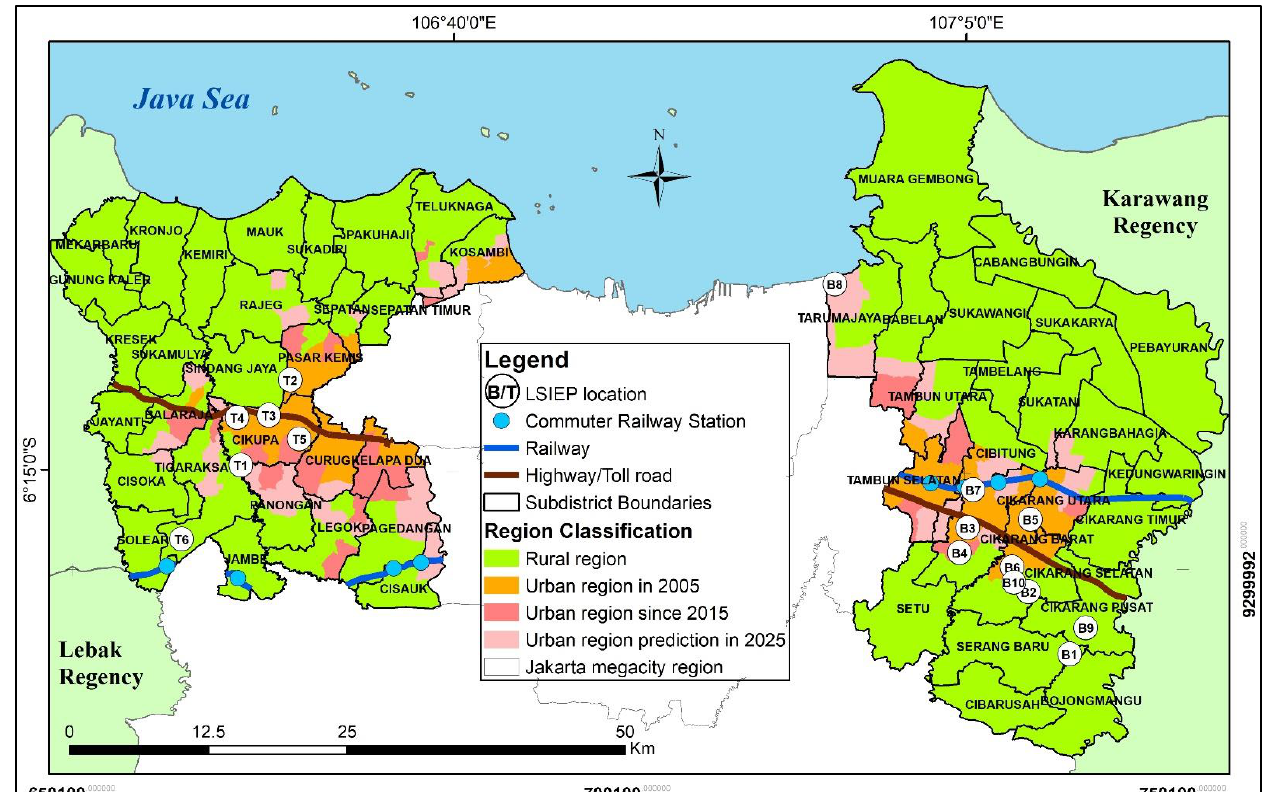
Figure 10. Regional typology prediction (2025) based on the RULT index.